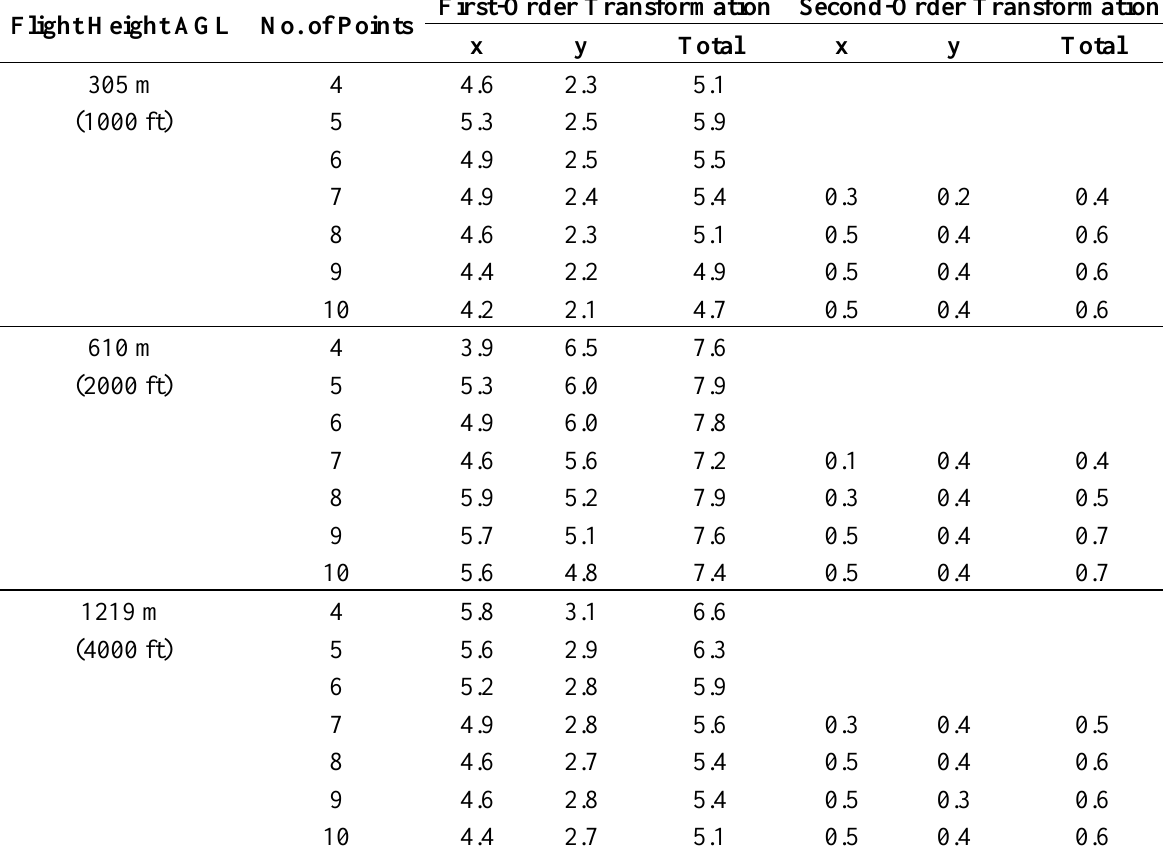
Table 3. Root mean square errors in pixels for registering near-infrared band images to normal color images acquired at 305, 610 and 1219 m (1000, 2000 and 4000 ft) above ground level (AGL) near Hargill, Texas using the first- and second-order transformations based on 4 to 10 control